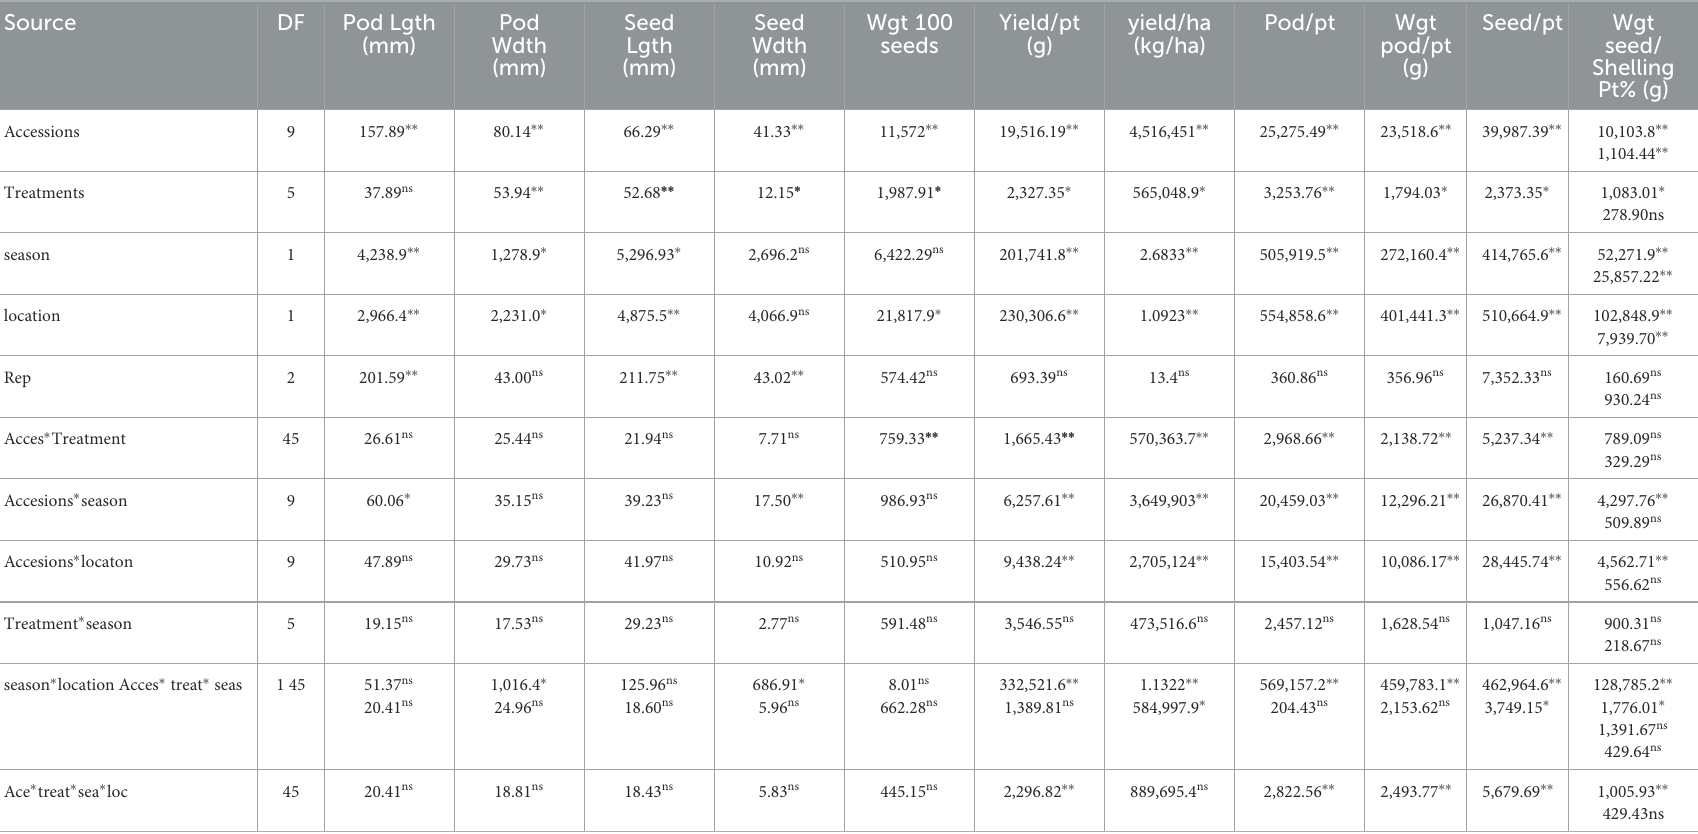
TABLE 8 Analysis of variance showing the effect of treatments on yield and yield components of BGN accessions in Ibadan and Ikenne in both seasons.